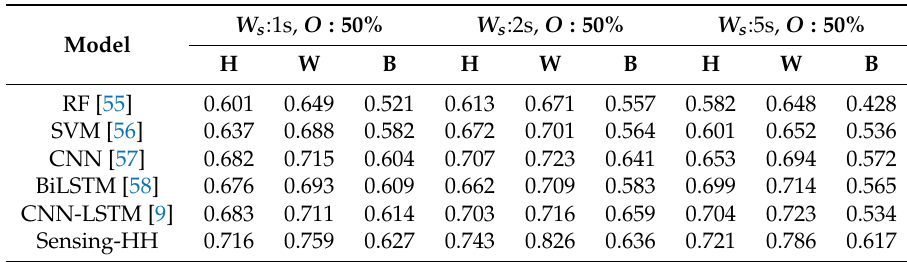
Table 4. Performance comparison measured by F m , where W s and ‘O’ are short for ‘Size of Sub-sequence’ and ‘Overlap of the adjacent sub-sequence or cycle’, where ‘H’, ‘W’ and ‘B’ are short for ‘Hand’, ‘Waist’ and ‘Bag’. Sensing-HH achieves the best results on most parameters, significantly outperforming the